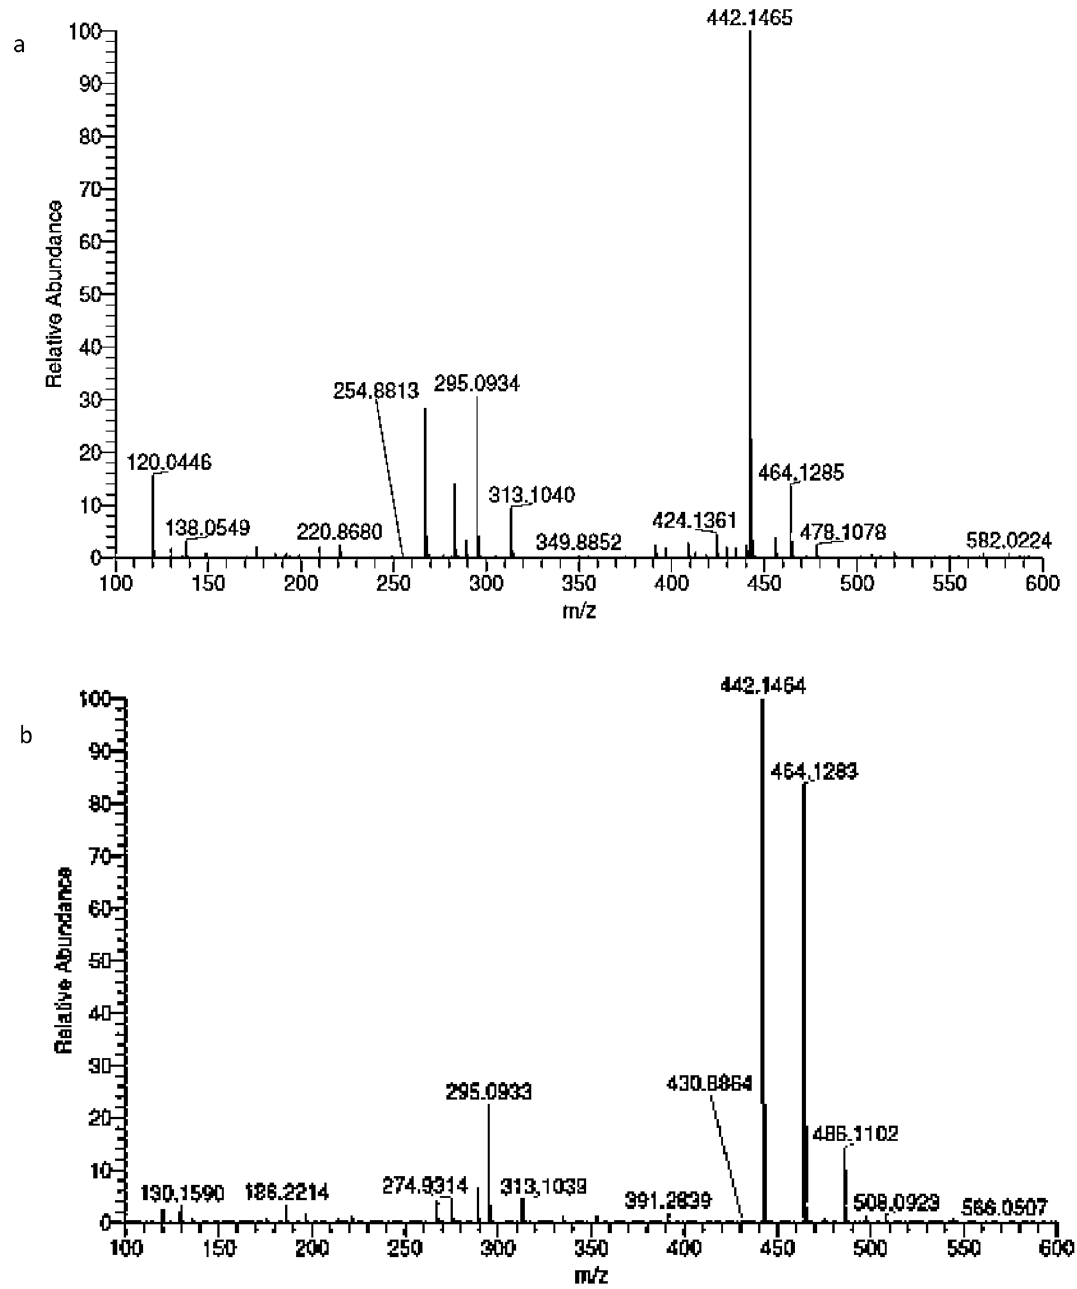
Figure 1. Mass spectrum of folic acid in spray solution ( a ) folic acid in sodium carbonate solution ( b ) folic acid and potassium iodate in sodium carbonate solution.